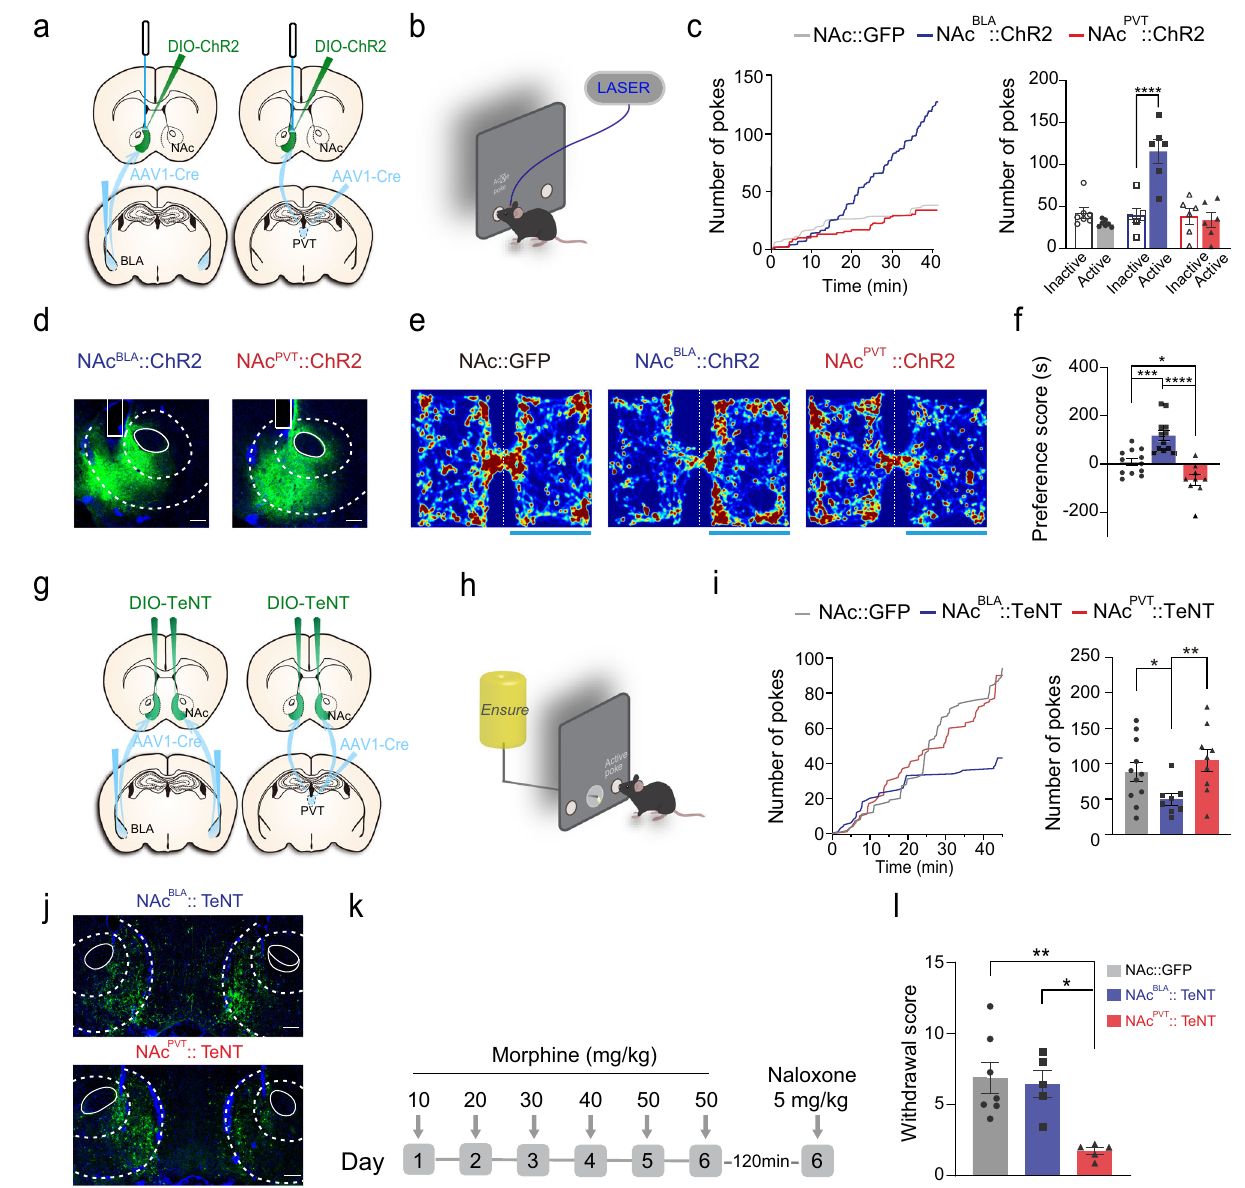
Fig.2|FunctionaldivergenceofNAc BLA andNAc PVT subpopulations.a Schematic showing the viral strategy to activate NAc BLA or NAc PVT neurons. b Schematic illus- trating optogenetic self-stimulation task. c Left: example cumulative curves of the number of active nose-pokes made in 40min behavioral sessions (FR=1). Right: average numbers of nose-pokes for NAc::GFP ( n =7), NAc BLA ::ChR2 ( n =6) and NAc PVT ::ChR2 mice ( n =6). Two-way ANOVA: ChR2×poke ( F (2,32) =16.27, P <0.0001), followed by post hoc Sidak ’ s test. P <0.0001), ChR2 ( F (2,32) =15.41, **** P <0.0001. Mean±s.e.m. d Examples of viral expression and locations of optic fi bers.Scalebar:200 μ m. e Representativeheatmapsforreal-timeplacepreference test. Left: non-laser paired side; Right: laser paired side. f Quanti fi cation of pre- ference score in real-time place preference test for NAc::GFP ( n =12), NAc BLA ::ChR2 ( n =12) and NAc PVT ::ChR2 ( n =9) mice. One-way ANOVA ( F (2,30) =21.94, P